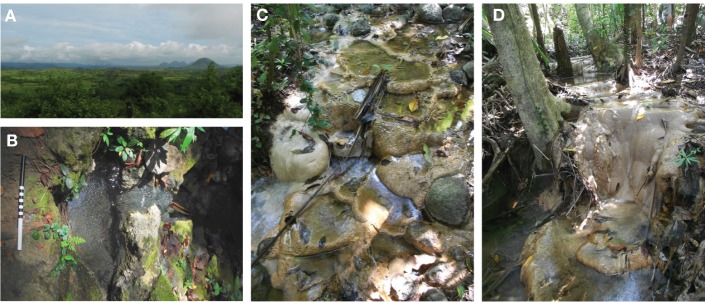
Site location. (A) The hilly terrain of the Zambales ophiolite range in Luzon, Philippines. (B) The source seep at Manleulag Spring National Park (scale bar = 30 cm). (C) Terraces and rimstone dams, 9.9 m from source. (D) A large accretion of terraces on tree roots and fallen branches, 19.5 m from source.